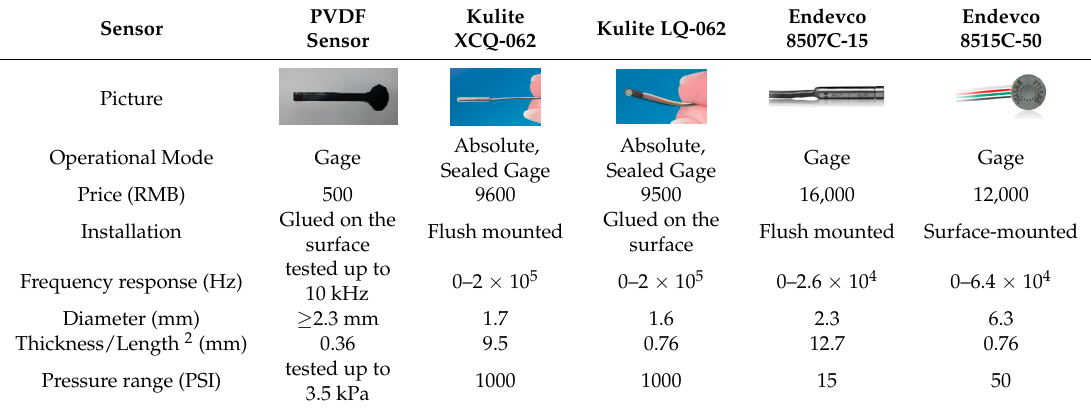
Table 2. Comparison between the PVDF sensor and common pressure transducers 1 .